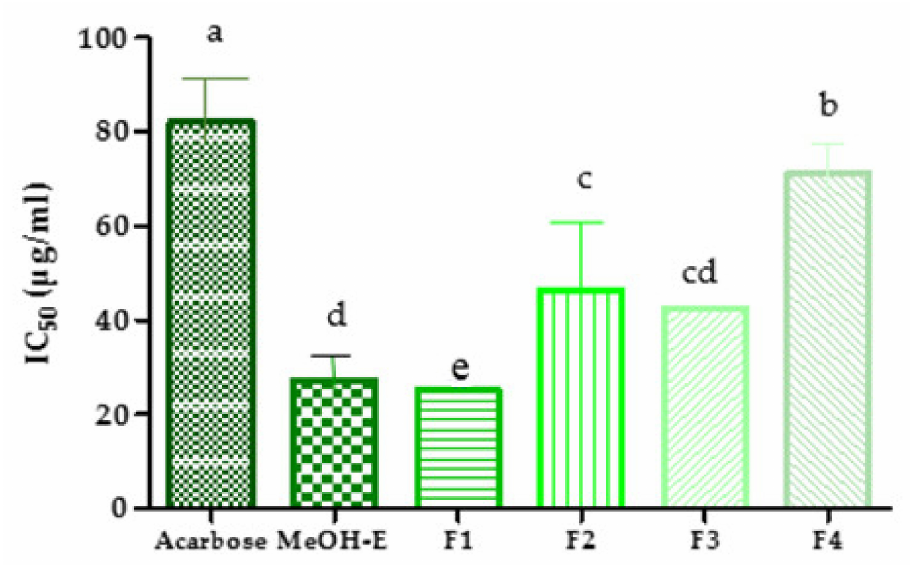
Figure 3. Inhibitory ability of pancreatic α -amylase (IC 50 in µ g/mL) by R. raetam methanolic extract (MeOH-E) and the subsequent fractions (F1, F2, F3, F4). Means with different superscripts (a–e) are significantly different at p <